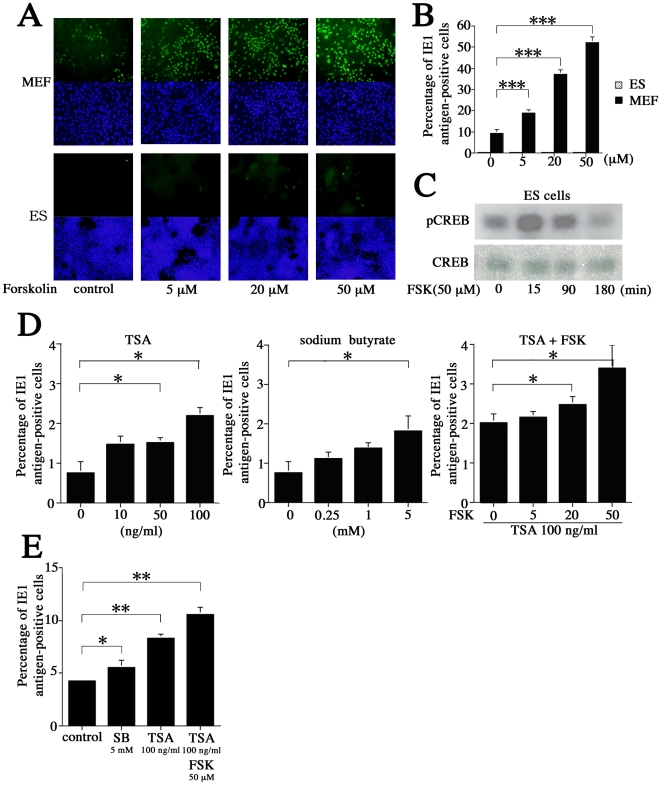
Response of the MCMV lytic cycle to treatment with FSK and TSA.Both (A) immunocytochemical and (B) flow cytometric analyses showed that treatment with FSK increases the proportion of IE1-positive cells in MEF cultures in a concentration-dependent manner (P<0.001), while only slight increases were seen in ES cells. (C) Western blot evaluating levels of phosphor-Ser 133 CREB after treatment with FSK. (D) Percentage of IE1 antigen-positive cells at 24 hpi in ES cells infected with MCMV at an MOI of 1 prior to treatment with TSA (left), sodium butylate (SB; middle), and a combination of TSA (100 ng/mL) and FSK (0–50 µM; right). (E) Percentage of IE1-positive cells in ES cells infected with MCMV at an MOI of 10 prior to treatment with SB (5 mM), TSA (100 ng/mL), or a combination of TSA (100 ng/mL) and FSK (50 µM). All presented experiments were performed at least 3 times, and data are given as the mean±SD. * P<0.05. **P<0.01, *** P<0.001, t-test.